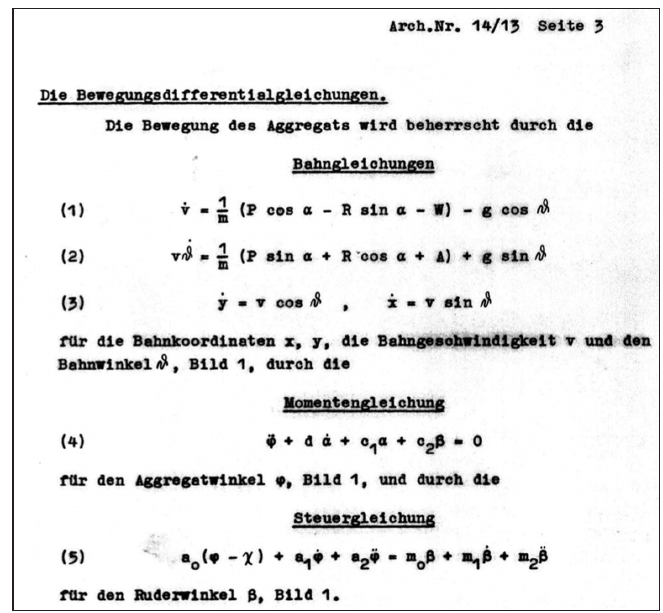
Figure 6: Fundamental equations concerning the calculation and control of the flight path of the V-2 rocket. (1) to (3) are path equations, (4) is the equa- tion of moments, and (5) is the steering equation (ARCH 14/13). Reproduced with permission of the archive.